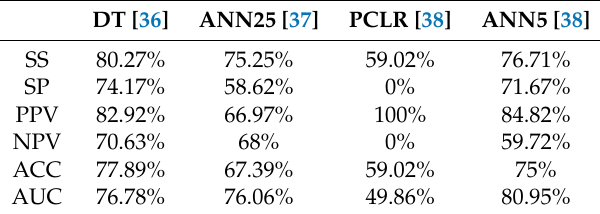
Table 10. Performance indicator versus technique using hold out validation with IDF criteria.